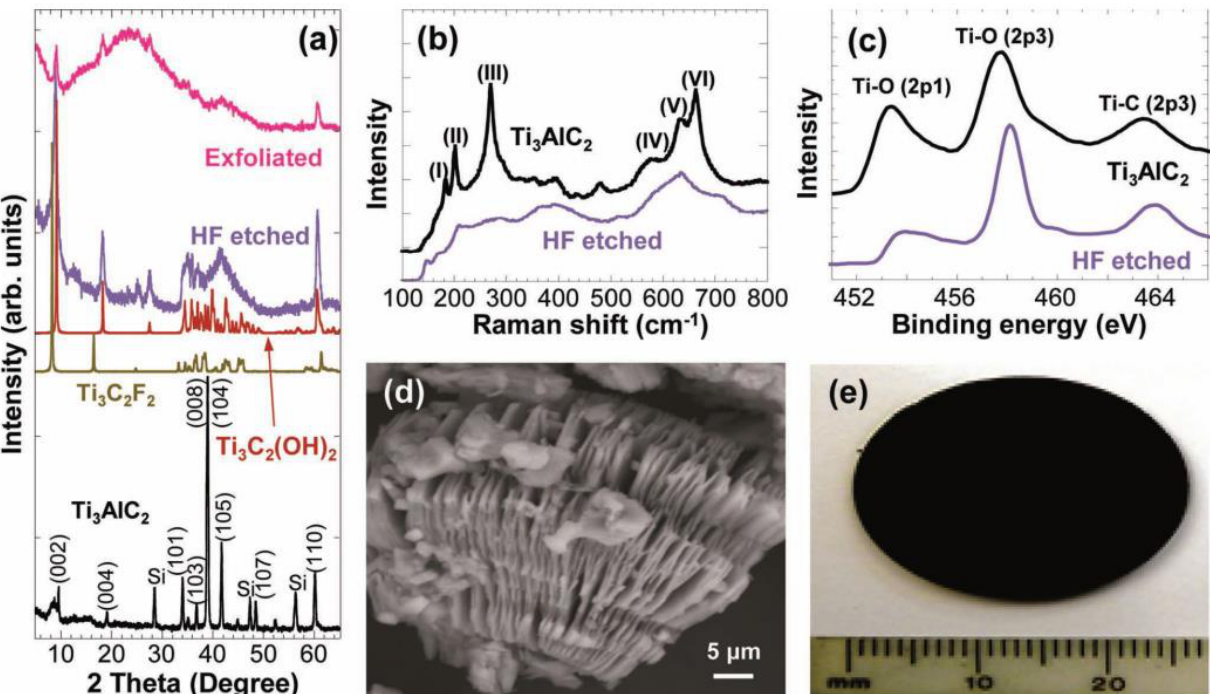
Figure 3. ( a ) XRD pattern, ( b ) Raman spectra, ( c ) XPS spectra of the Ti 3 AlC 2 before and after exfoliation. ( d ) SEM image and ( e ) Cold-pressed disk of etched and exfoliated material after HF treatment. Reproduced with permission [7]. Copyright 2014, John Wiley and Sons.